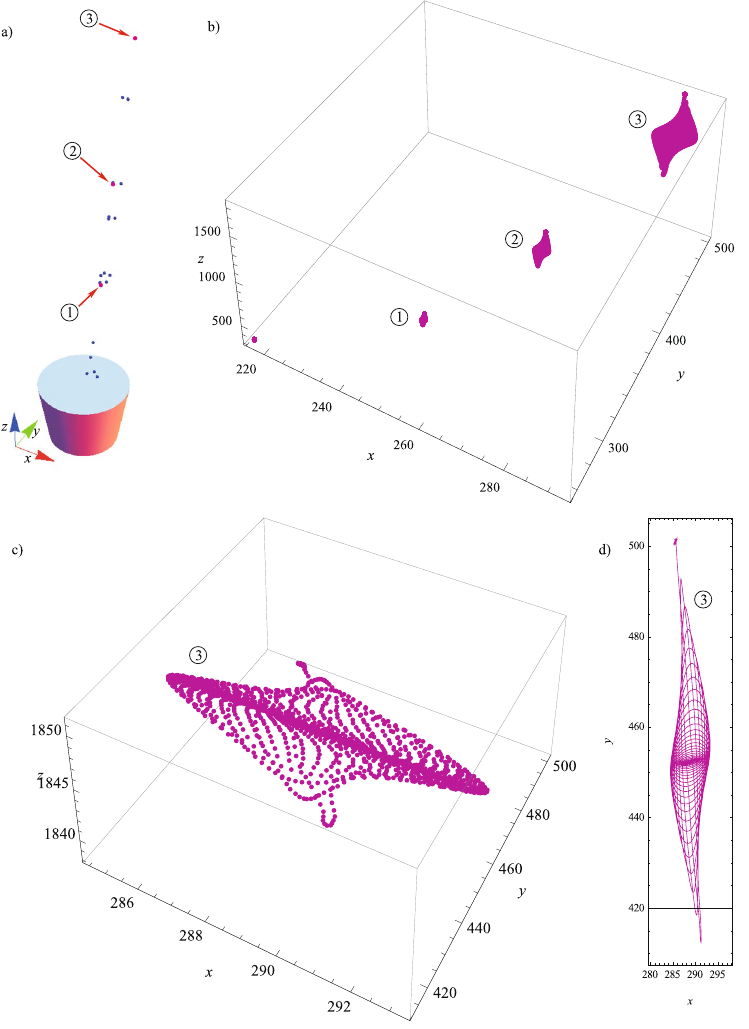
Figure 2. ( a ) The arrangement of all the markers obtained in Wolfram Mathematica and three Markers of interest (1, 2 and 3); ( b ) Trajectories of Markers 1, 2 and 3; ( c ) Trajectory of Markers 3 in 3D; ( d ) Trajectory of Markers 3 in the x-y